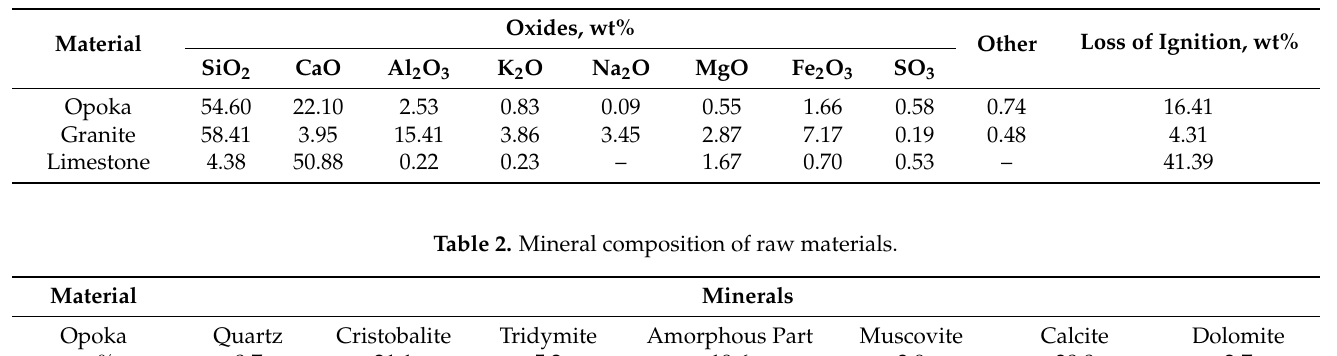
Table 1. Chemical composition of raw materials obtained by Rietveld method.